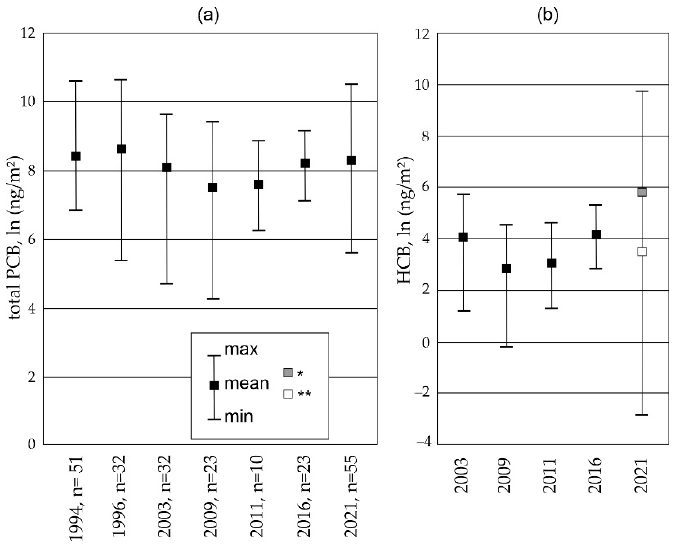
Figure 2. The comparison of the total PCB ( a ) and HCB ( b ) levels in snow from the 1990s to the 2020s (ln (ng/m 2 )) (* mean HCB levels including data for Site # 31 near the industrial area of Usol’ekhimprom; ** mean HCB levels without data for Site # 31) [16,21-24, and present study].